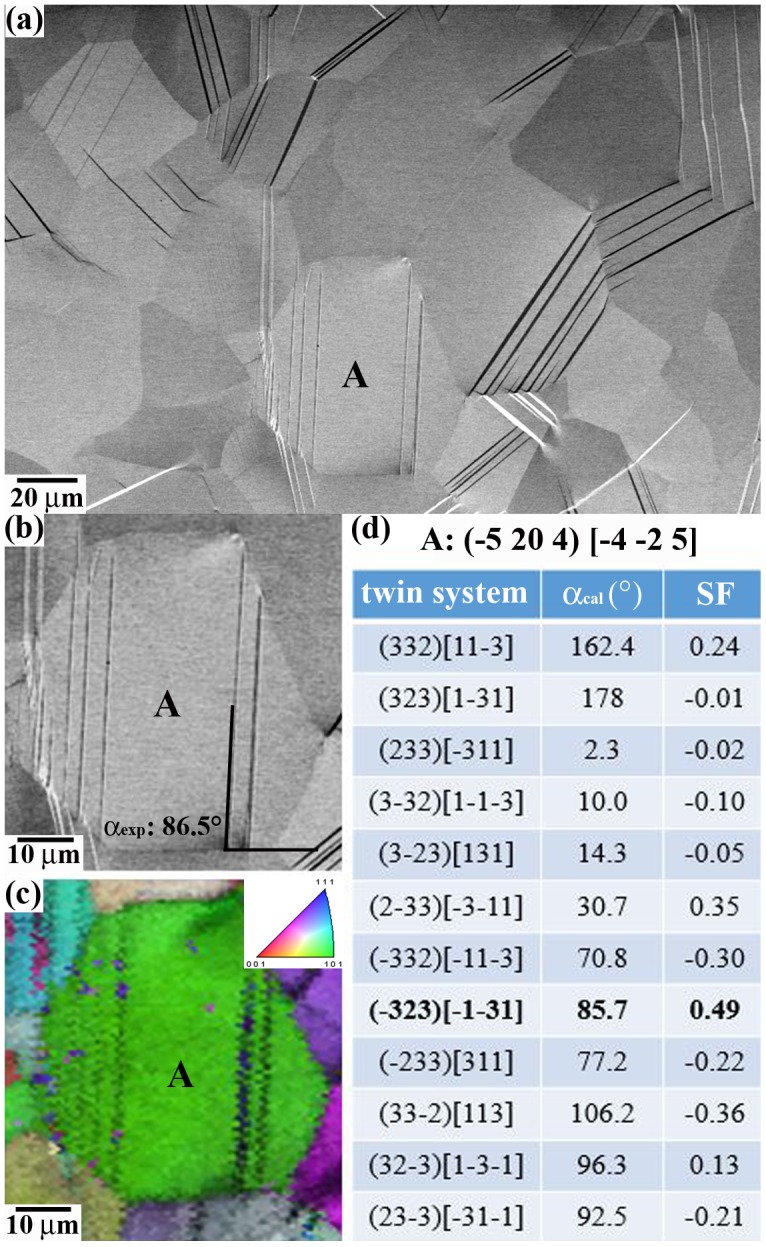
Scheme of the twin plane trace approach. (a): BSE-SEM image of the twin structure of the SG sample strained to 425 MPa/ε: 0.3%. (b)–(d): Example of twin plane analysis of grain A marked in (a). α
exp: angle between surface twin plane trace and rolling direction; α
cal: angle between rolling direction and trace projection of the twin plane onto the RD-TD plane; SF: Schmid factor.